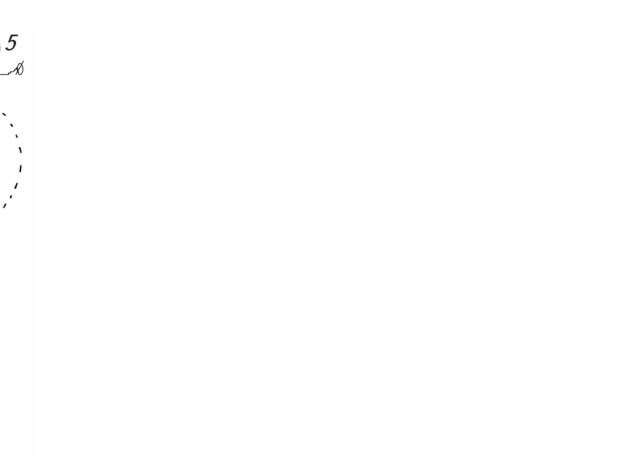
Figure 3. Scheme of the device for measuring internal stresses in the coating directly during CW spraying to the surface of the ring: 1—ring with a longitudinal section (specimen); 2—rods for fixing the strain-gauge sensor; 3—strain-gauge sensor to measure of displacement of the edges of the longitudinal section of ring; 4—screen to protect the strain-gauge sensor from melt drops of CW; and 5—electric wires from the strain-gauge sensor to the measuring device.